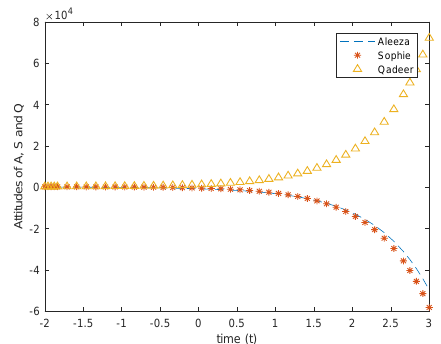
Figure 10. Line graph for differential Equation (8).